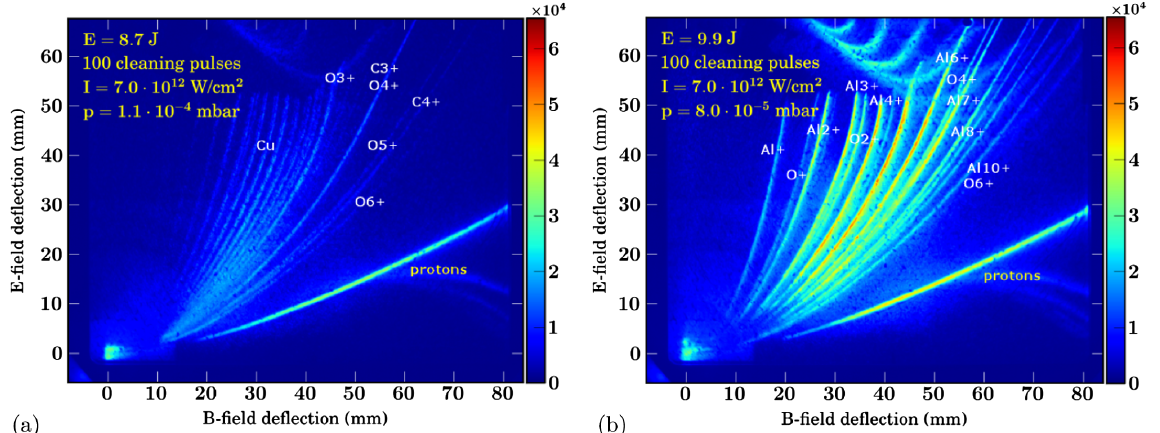
FIG. 5. Thomson parabola images of a shot on a Cu foil with a CPA pulse energy of 8.7 J in (a), and on an Al foil with a CPA pulse energy of 9.9 J in (b) are shown. In both cases, 100 cleaning pulses on both target surfaces were irradiating the target prior to the CPA pulse.